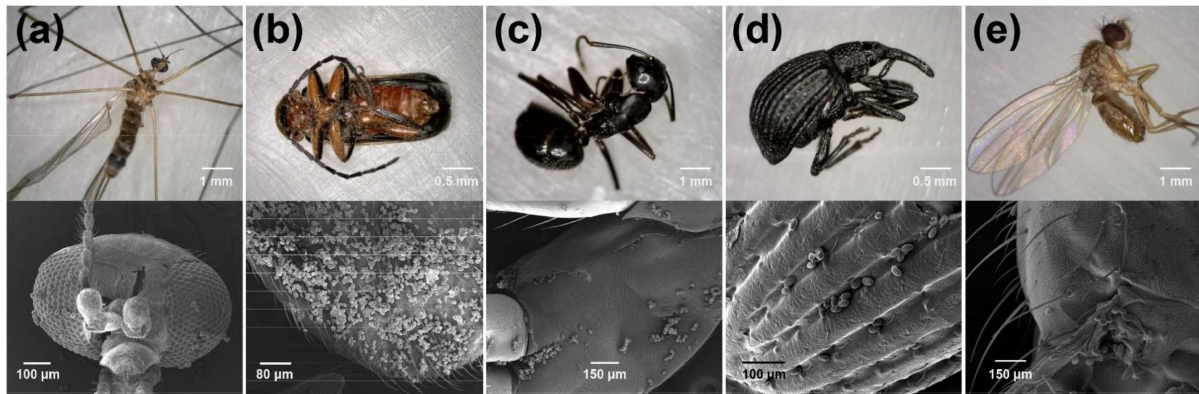
Figure 5. Black cherry pollen grains found on insect body: ( a ) Antocha sp. (Diptera: Limoniidae); ( b ) Atalantycha bilineata (Coleoptera: Cantharidae); ( c ) Camponotus pennsylvanicus (Hymenoptera: Formicidae); ( d ) Trichopion sp. (Coleoptera: Curculionidae); ( e ) Drosophilinae (Diptera: